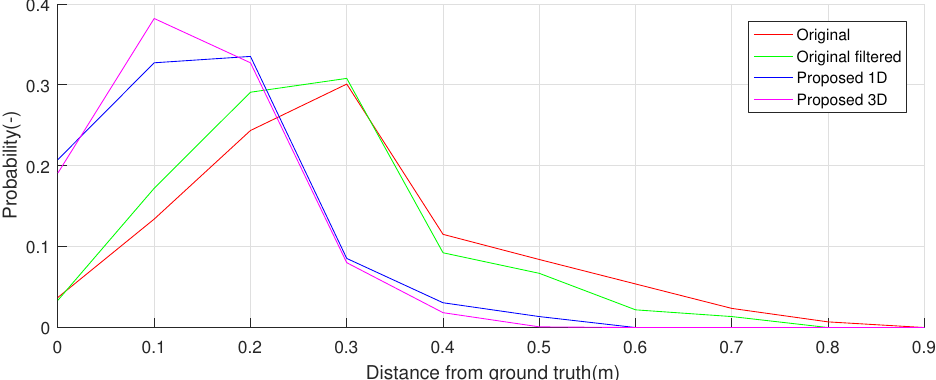
Figure 14. Error of the ground-truth reference with respect to the possible localization strategies. The 3D version of the proposed method is the solution that achieved the minor error and thus the best localization